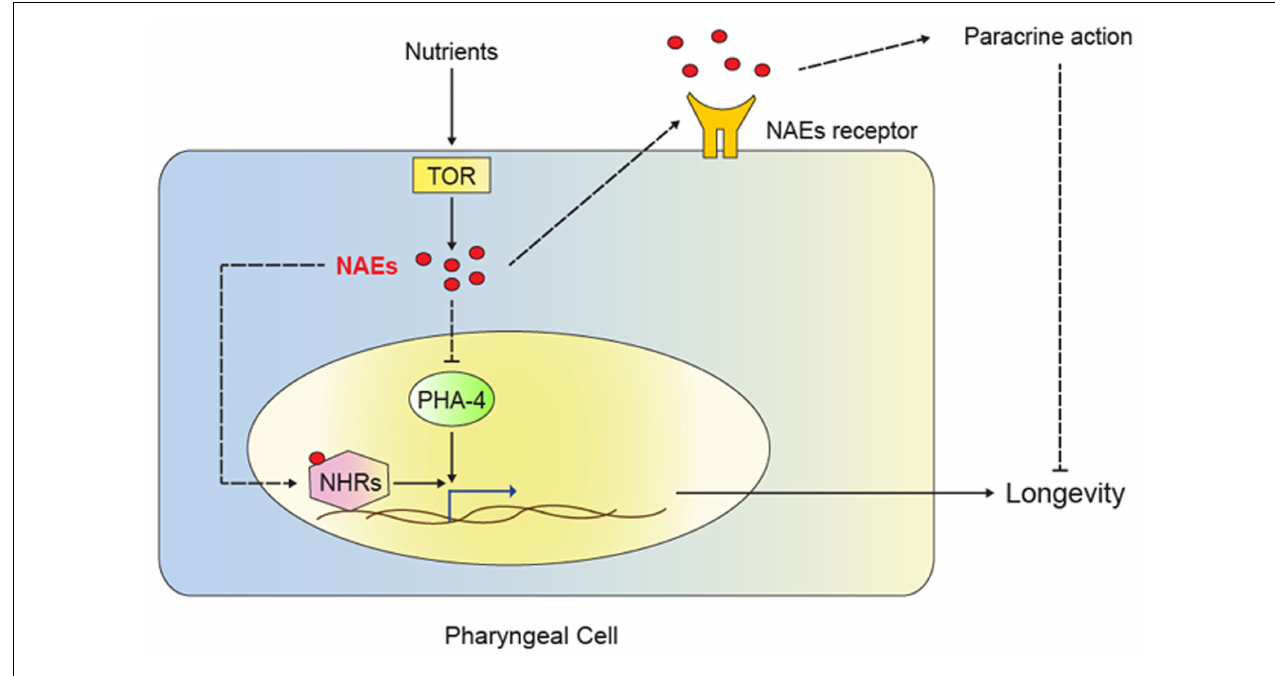
inhibit the transcription factor PHA-4 and therefore repress genes required for dietary restriction-induced longevity. Lastly, NAEs could act as ligands for nuclear hormone receptors (NHRs) and result in the regulation of genes required for dietary restriction-mediated longevity. Low NAE levels signal dietary restriction and result in activation of the transcription of genes that contribute to extension of